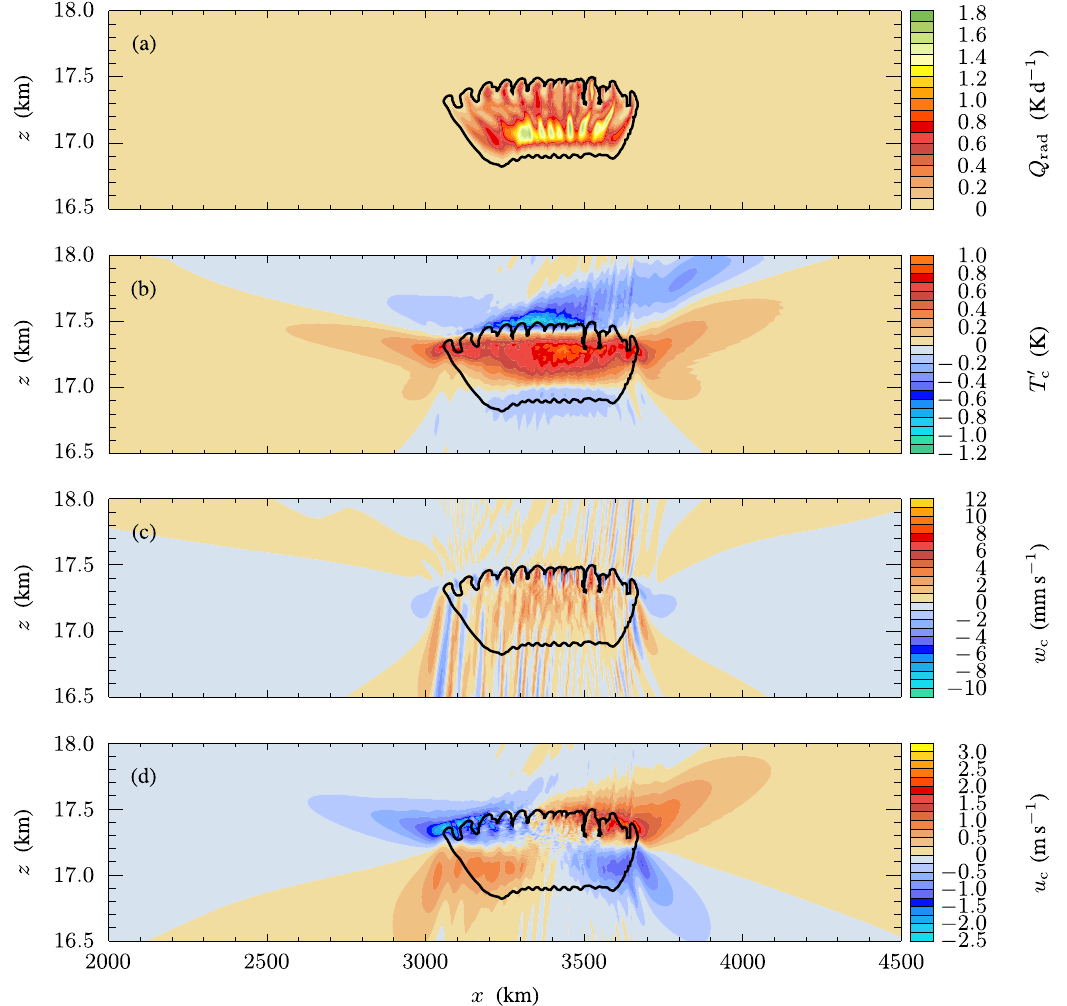
Fig. 8. The radiative heating (a) , and induced temperature perturbations (b) , vertical velocity (c) and horizontal velocity (d) at 3 . 5d. The black outline in each figure marks the radiative heating rate contour of 0 . 01Kd − 1 . Note that the vertical scale is exaggerated by a factor of about 10 3 to 1 compared with the horizontal